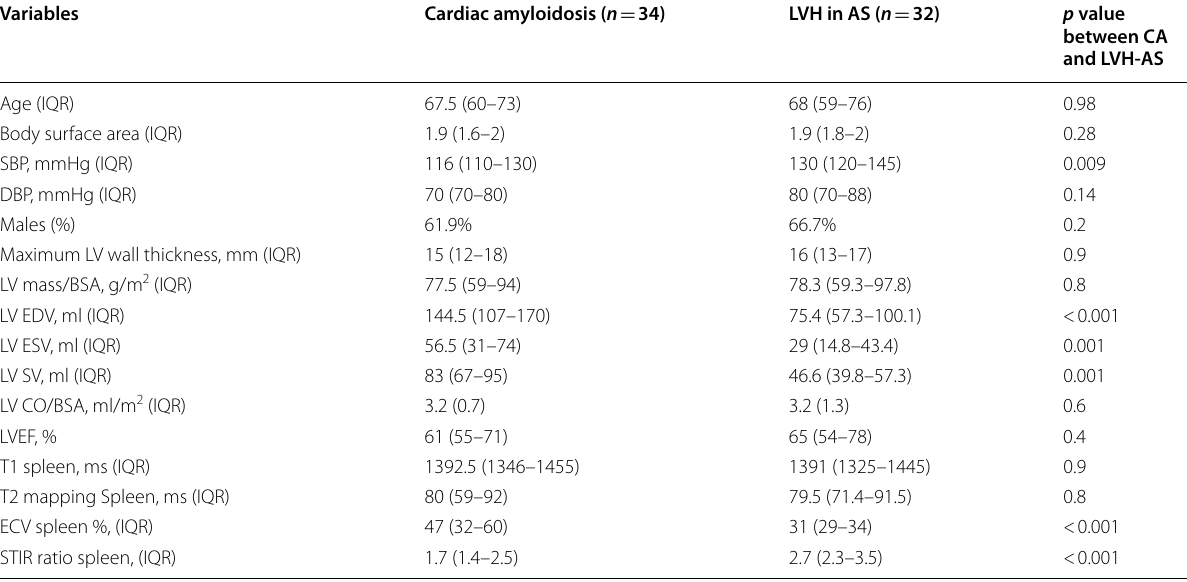
CA cardiac amyloidosis, LVH-AS left ventricular hypertrophy in the setting of aortic stenosis, BSA body surface area, LV left ventricular, IQR interquartile range, SBP systolic blood pressure, DBP diastolic blood pressure, EDV end diastolic volume, ESV end systolic volume, SV stroke volume, CO cardiac output, EF ejection fraction, ECV extracellular volume, STIR short tau inversion recovery